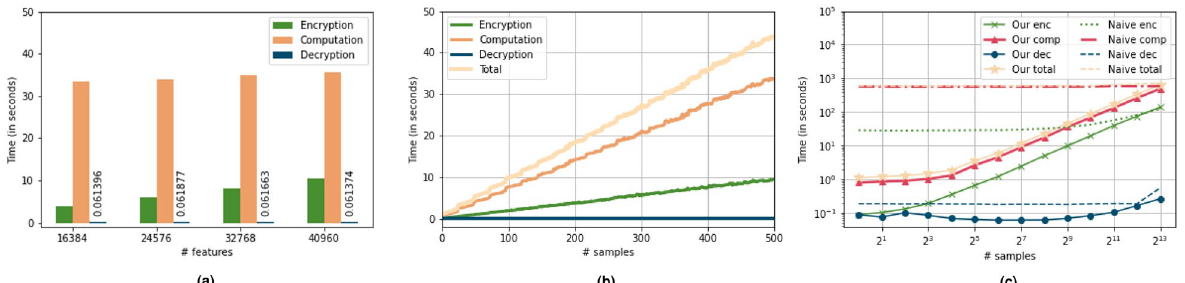
Figure 5. Experimental analysis: ( a ) performance of our private LR-based cancer prediction model as a function of features. ( b ) Timing for different operations as a function of number of test samples. ( c ) Latency comparison of our matrix multiplication algorithm with standard privacy-preserving matrix